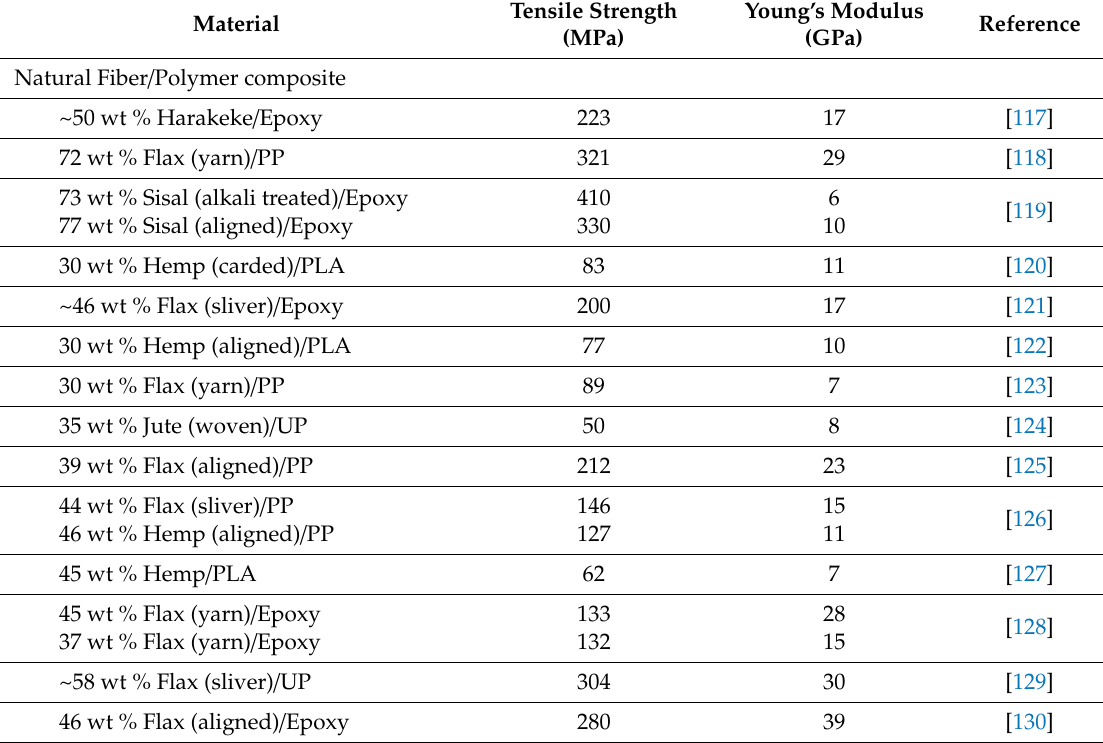
Table 2. Mechanical properties of natural fibers with graphene-based material, and their composites, used in Ashby plot.